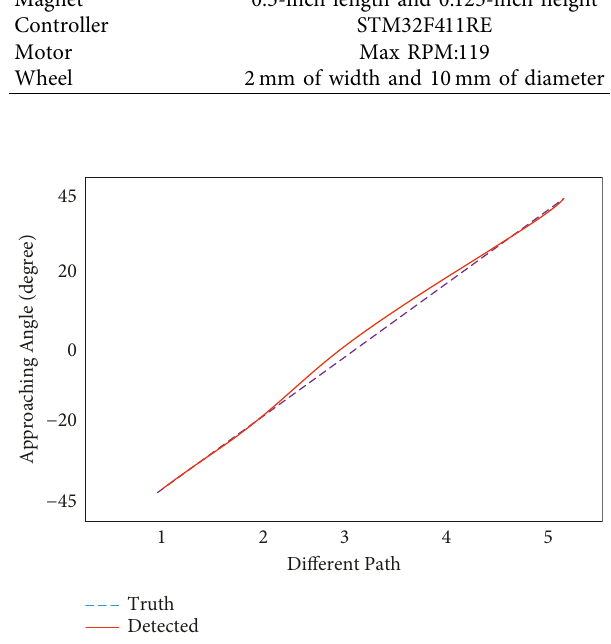
Figure 7: Accuracy of angle